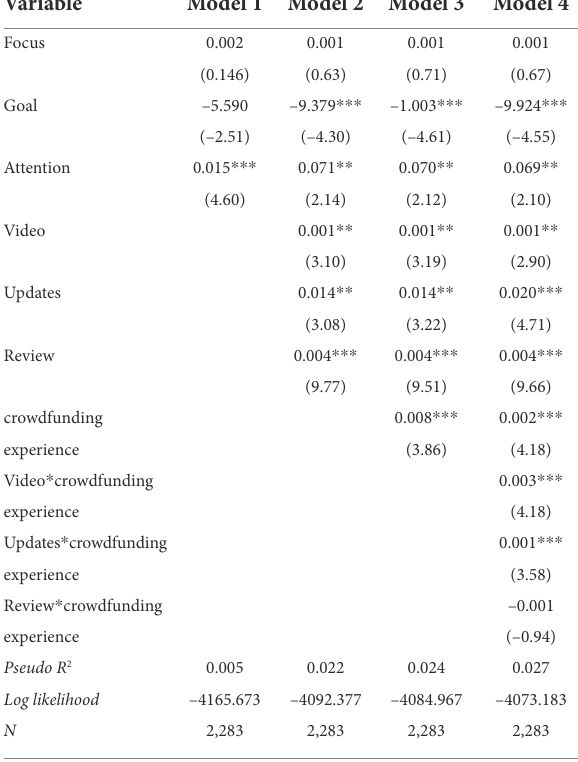
TABLE 6 Analysis of regression results of tobit